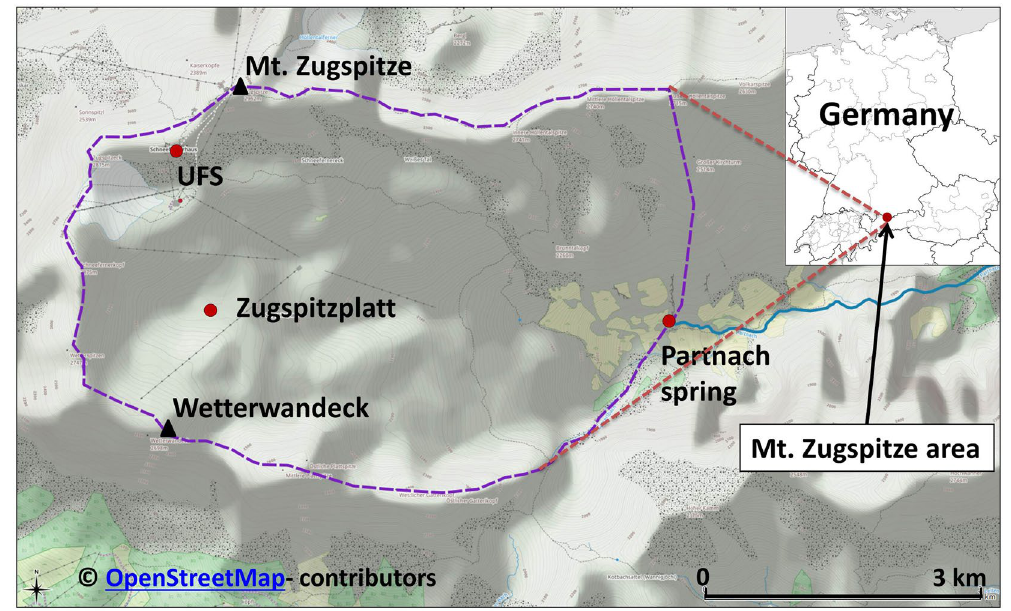
Figure 1. Catchment of Mt. Zugspitze (purple line), Partnach spring and sampling areas UFS and Zugspitzplatt 22 . Map data © OpenStreetMap contributors